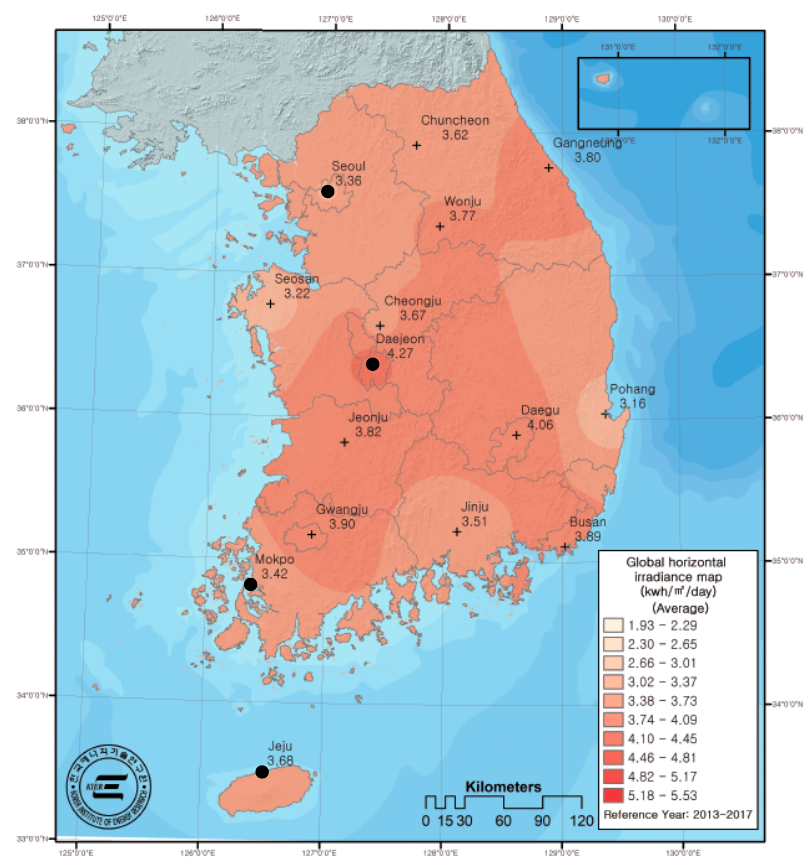
Figure 3. GHI map of South Korea [13].